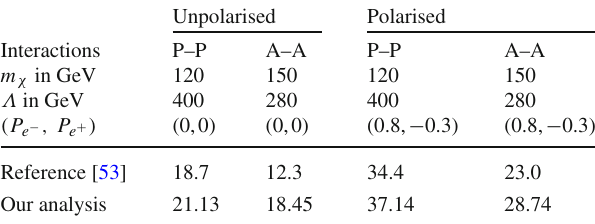
√ S + B of the process e + e − → j j + (cid:15) E T at Table 6 Efficiency S / = 500 GeV and an integrated luminosity L = 100 fb − 1 corresponding to the benchmark points mentioned in Ref. [53] for both unpolarised and polarised initial beams. The respective coupling of DM with the charged lepton α e is taken to be MN